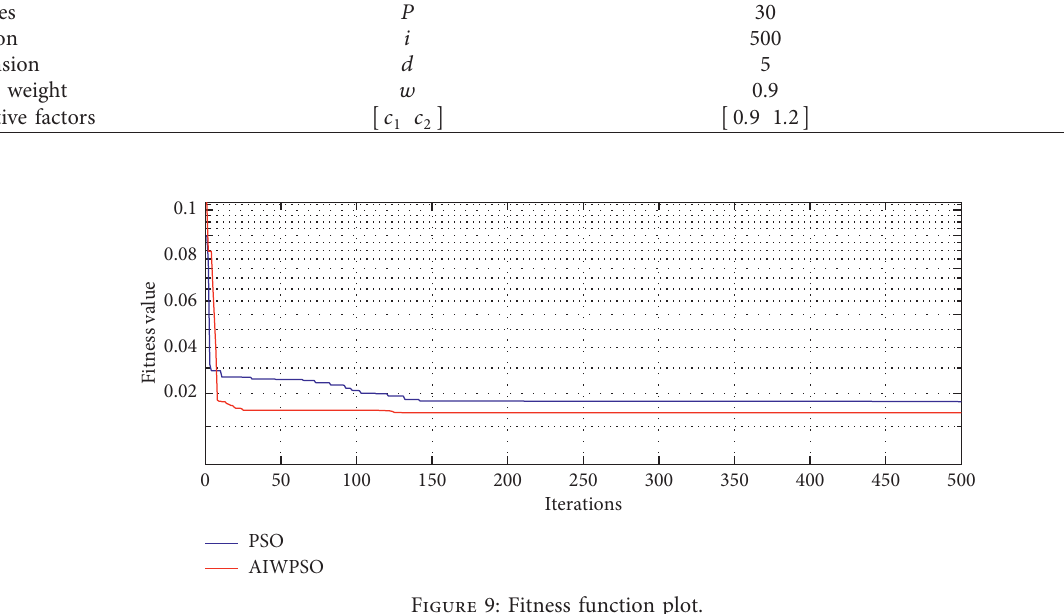
Figure 9: Fitness function plot.